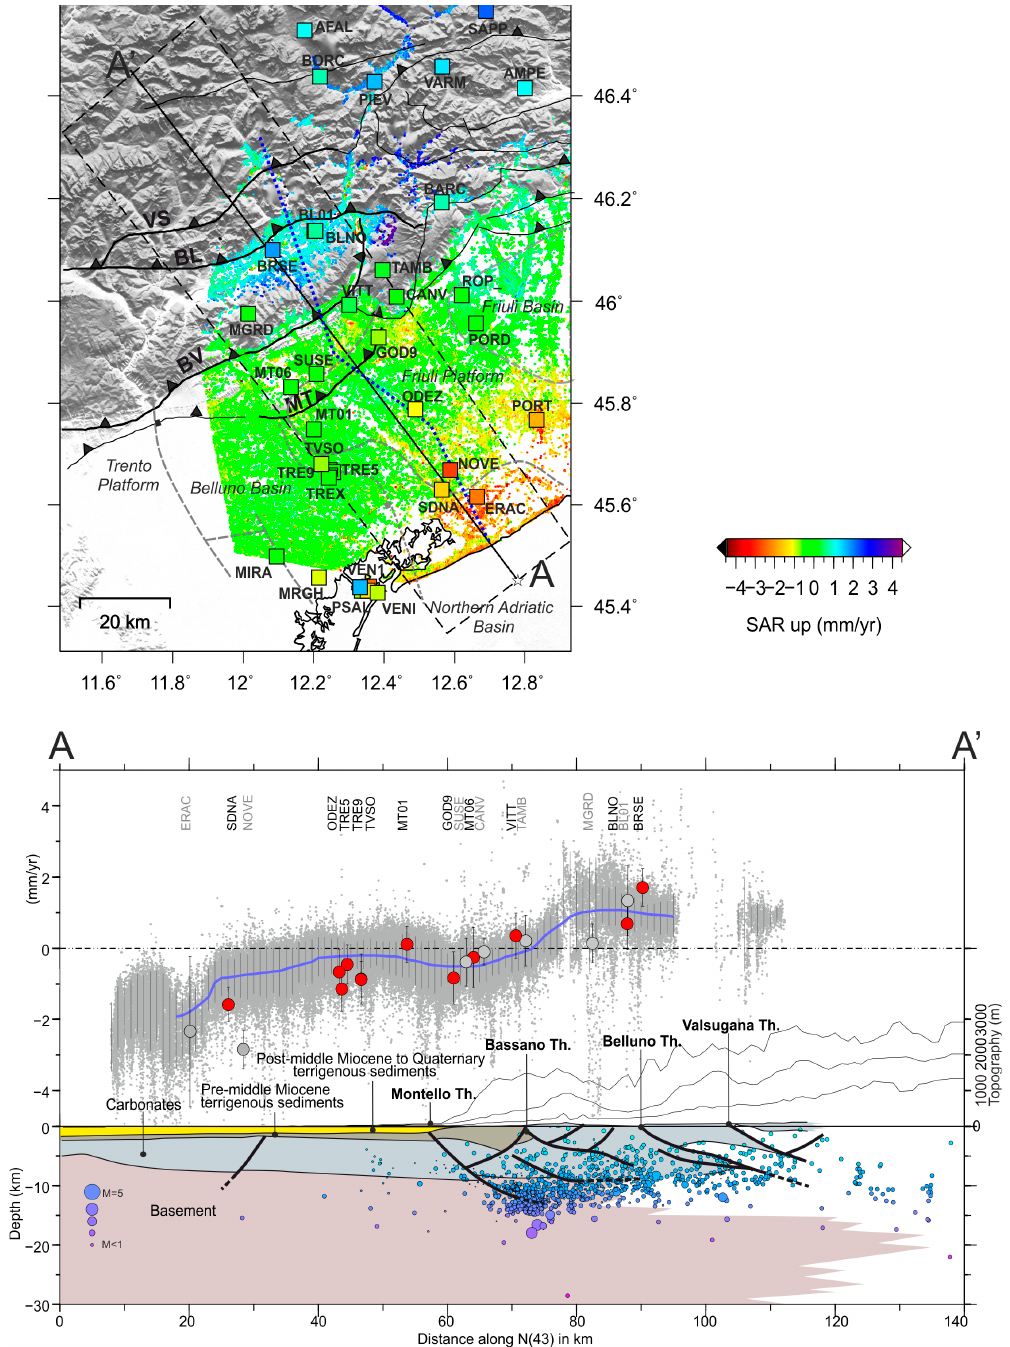
Figure 6. Vertical velocity profile across the Alpine system (Dolomites). Top : the map shows the vertical velocity values for each PS, while the colored squares indicate the vertical velocity of the GNSS stations, according to the InSAR multicolor scale on the right (blue = uplift; red = subsidence). The blue dotted line represents the trace of the geological section reported below. The profile with a buffer of 20 km is 140 km long, and the white star indicates the starting point. Bottom : the plot shows the vertical SAR velocities (grey dots), whereas the blue line indicates the median value. The circles with relative uncertainties represent the vertical velocities of GNSS stations; specifically, the grey ones have not been used during the calibration. The geological section is modified from Fantoni and Franciosi [69].